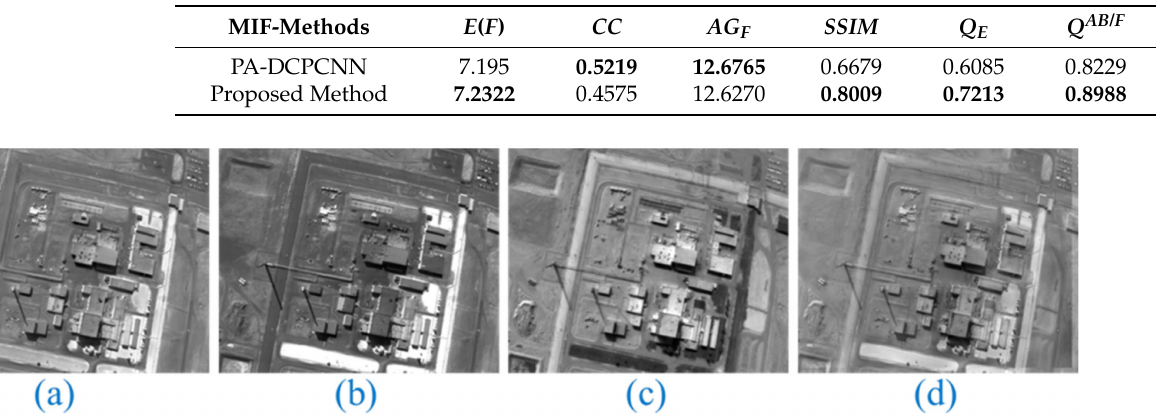
Figure 22. Multi-focus image of a remote sensing from various perspectives: ( a ) the original image, ( b ) the image with the left focus, ( c ) the image with the right focus, and ( d ) the image fused using the proposed